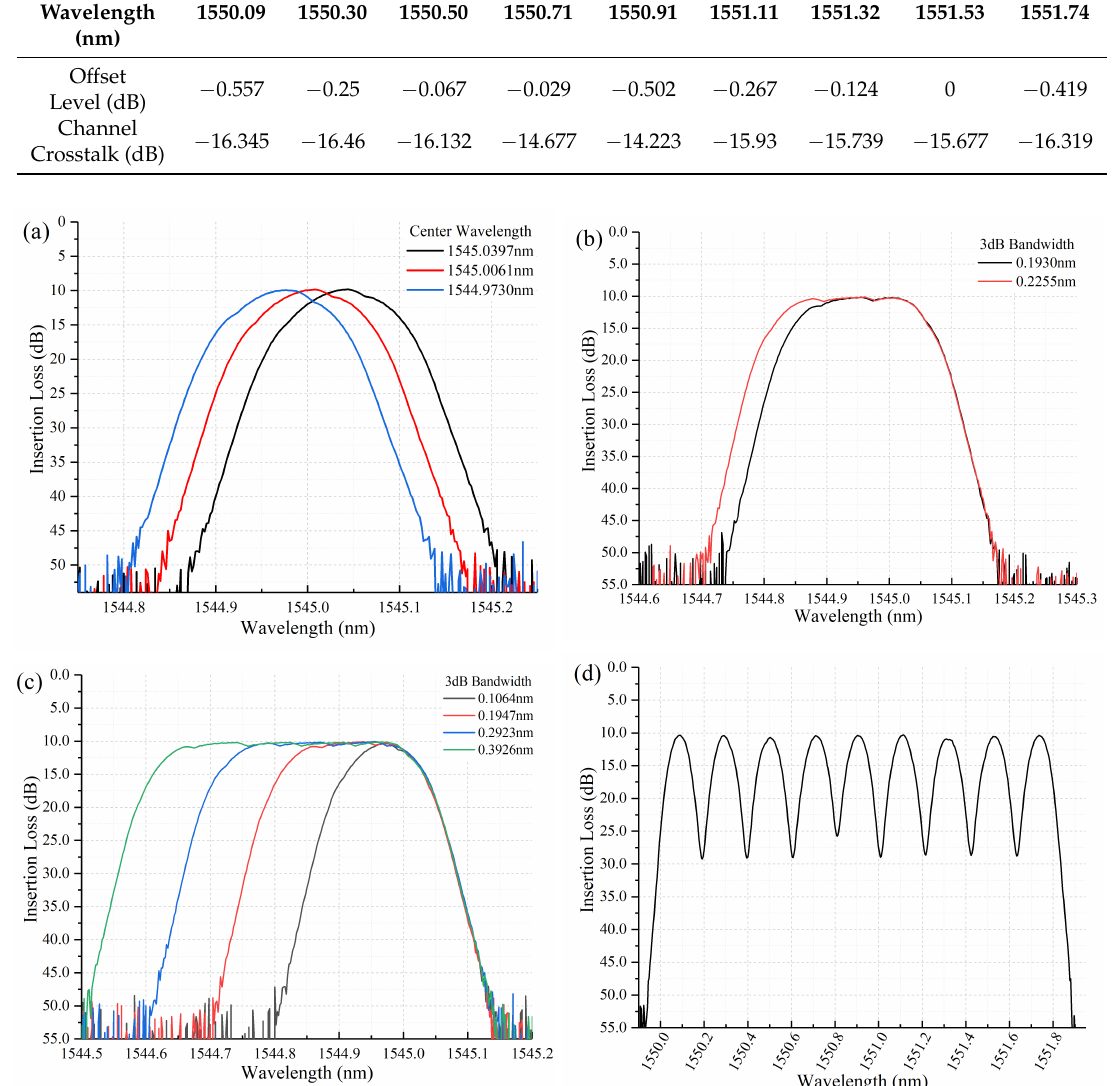
Figure 8. ( a ) The minimum tuning resolution of center wavelength in the filter. ( b ) The minimum tuning step of spectral bandwidth. ( c ) 3 dB-bandwidth from 12.5 GHz to 50 GHz with a step of 12.5 GHz. ( d ) Measured passband at 9 G.694.1 standard grid frequencies with 25 GHz channel